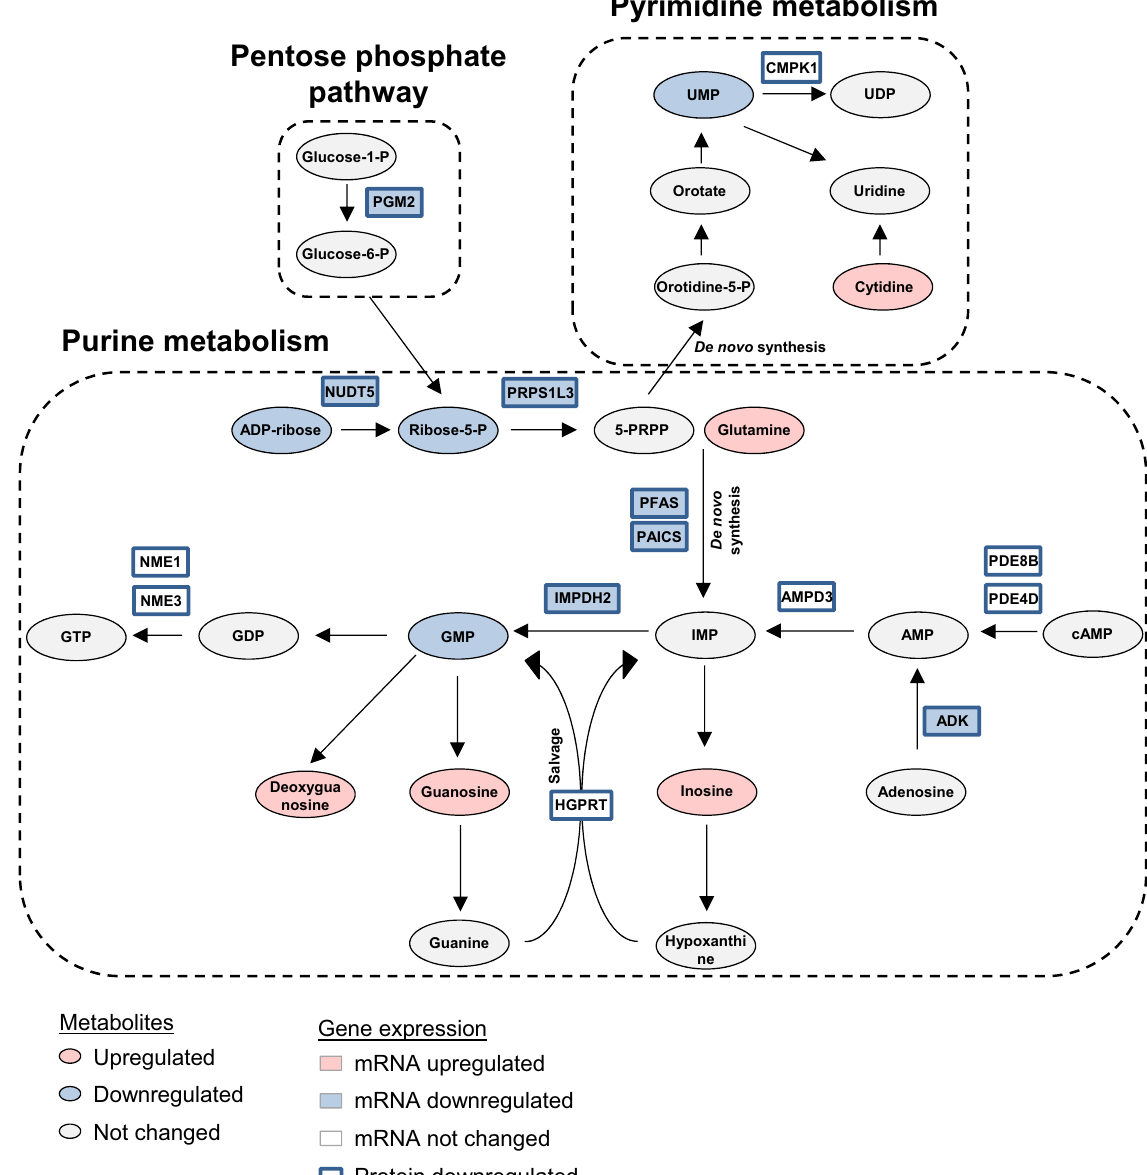
Figure 7. Concerted age-dependent regulation of nucleotide metabolism in BAT. Metabolic network representing nucleotide metabolism and integrating age-dependent regulation observed in metabolomic, proteomic and mRNA expression data analyses. Dashed line-boxes depict different metabolic branches of nucleotide metabolism: purine metabolism, pyrimidine metabolism and pentose phosphate pathway. Each oval represents a metabolite and each box represents a gene/protein. As shown in the legend, color-coding is provided for metabolites, genes and proteins enriched (red) or depleted (blue) during BAT-aging. Metabolites whose concentration was not affected by aging in BAT are shown in grey. Color-coding of metabolites is based on the log2 fold change (log2FC) values calculated in comparison to the young, 2.5-months control group (Supplementary Table S2). For each protein and gene, age-dependent regulation is represented by the same color-coding; genes whose mRNA was not changed during BAT-aging are depicted in white boxes. Proteomic changes are based on heavy/light ratios comparing young versus aged mice (Table